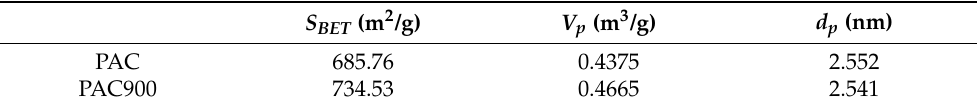
Figure 2. ( A ) N 2 adsorption – desorption isotherms and ( B ) mesopore size distribution by Barrett – Joyner – Halenda (BJH) method for PAC and PAC900. Table 1. Specific surface areas ( S BET ), total pore volume ( V p ), and average pore size ( d p ) of PAC and